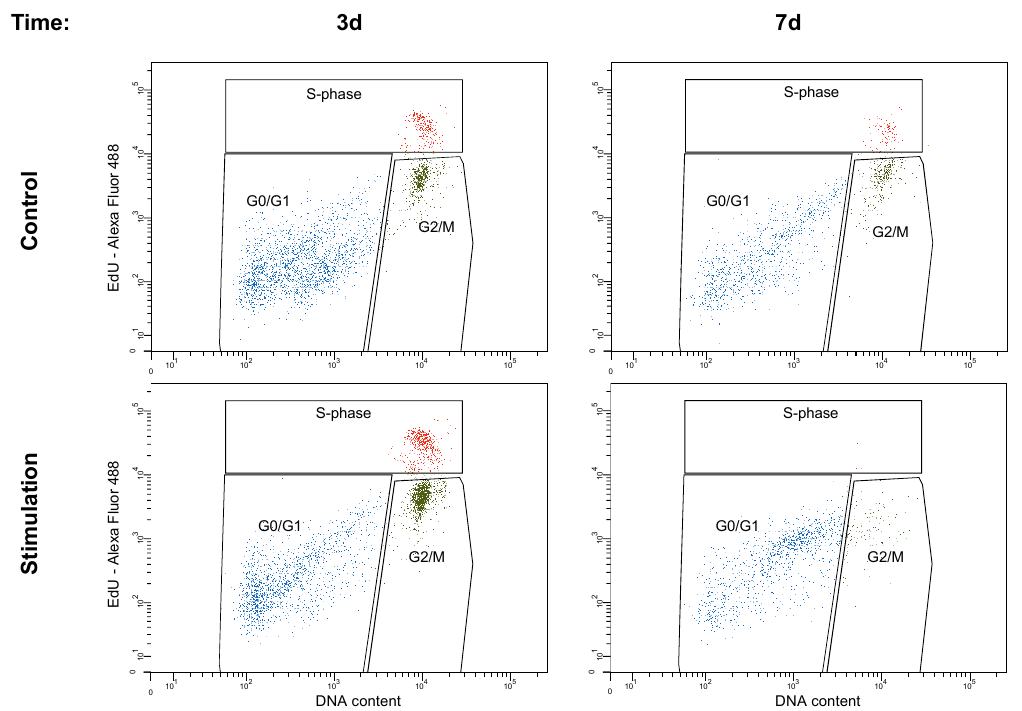
Figure 8. Histograms illustrating di ff erences in the cell cycle phases after 3 and 7 days for stimulated and non-stimulated (control) cells. Table 1. Distribution of cells within three phases of the cell cycle. Here, after three days, electrical stimulation led to a higher shift of stimulated cells (“stimulation”) in S and G2 / M phases when compared to non-stimulated controls (“control”). After seven days of electrical stimulation, an adverse e ff ect was